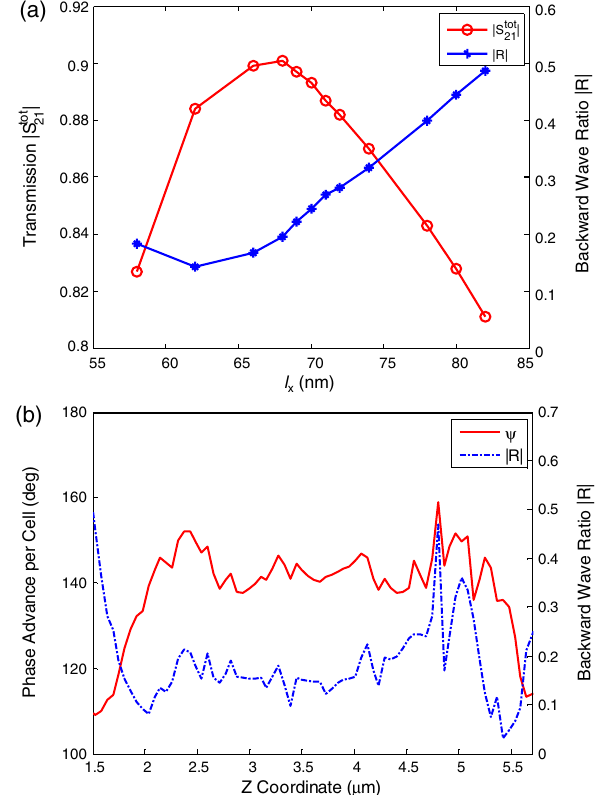
FIG. 7. (a) Effect on the total transmission j S 21 j and the normalized backward wave amplitude j R j in the accelerating waveguide as the reflection magnitude j S 22 m j of the mode launcher varies. (b) The phase advance per cell and the normal- ized backward wave amplitude as the mode launcher uses the 66 nm and z 863 tuning dimensions l 0 ¼ x ¼